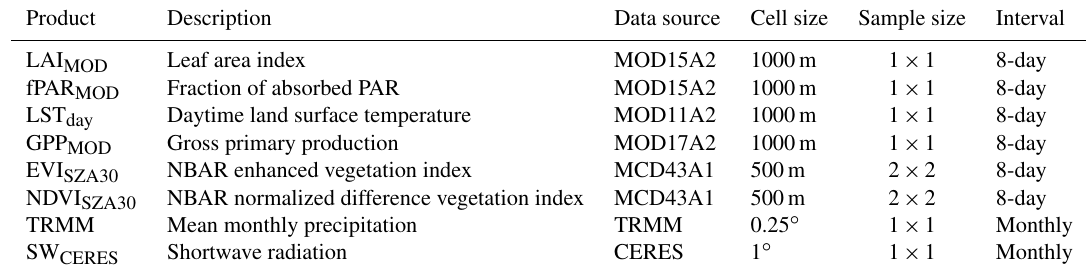
Table 2. Remote sensing data sources, cell size, sample size (eddy covariance tower site at the centre pixel), and time interval. Product Description Data source Cell size Sample size